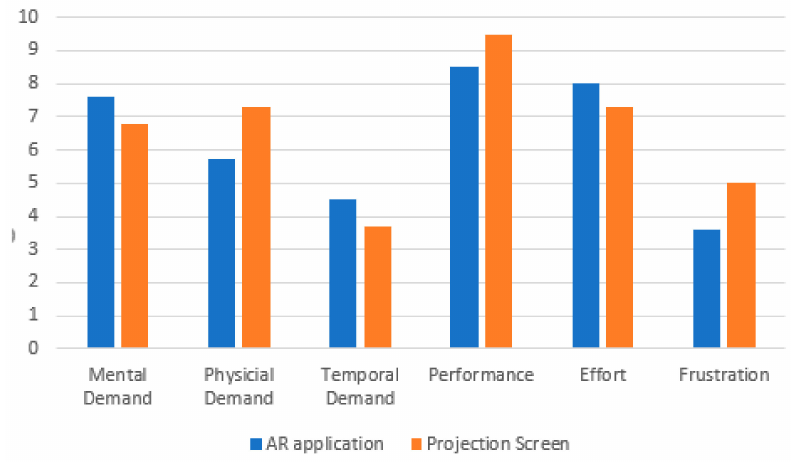
Figure 10. Comparison of average scores for NASA task load index (NASA-TLX)